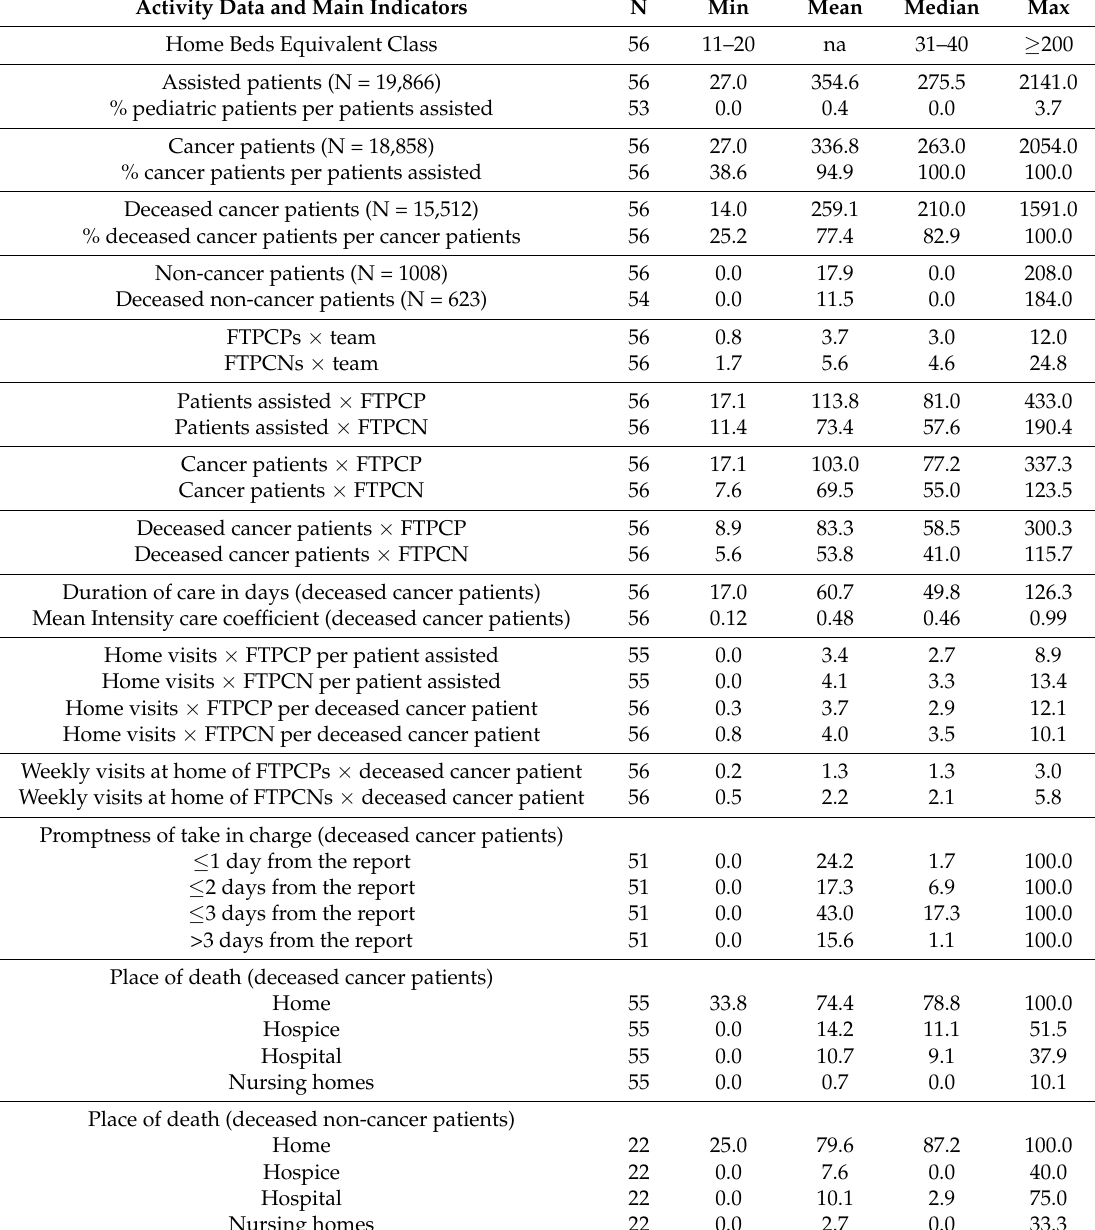
Table 4. Main activity indicators and outcome (N = 56 HPCSs of the Best Practice Panel). Activity Data and Main